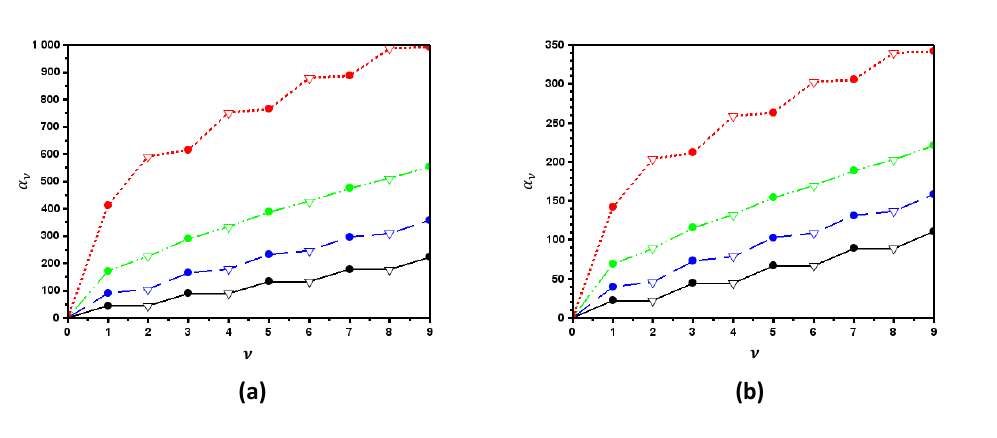
Figure 3: The variation of eigenvalue with the eigen-index for n = 0 (black solid line), -0.3 (blue dashed line), -0.5 (green dot-dashed line) and -0.7 (red dotted line) = 10 15 G pm − n , and (b) B = 5 × 10 14 G pm − n , and m = 0. Here the for (a) B 0 0 levels for − σ · B ( − B ) and + σ · B ( + B ) are marked by the solid circles and triangles 0 0 respectively.